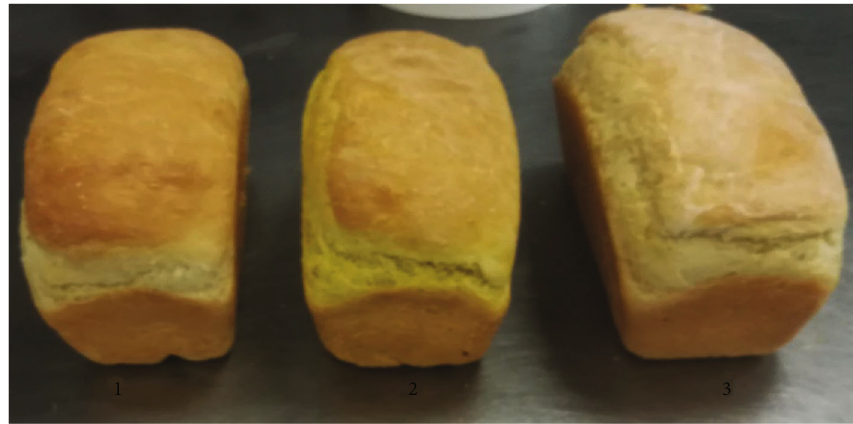
Figure 5: Photo of prototype bread (1: control; 2: sample 1; and 3: sample